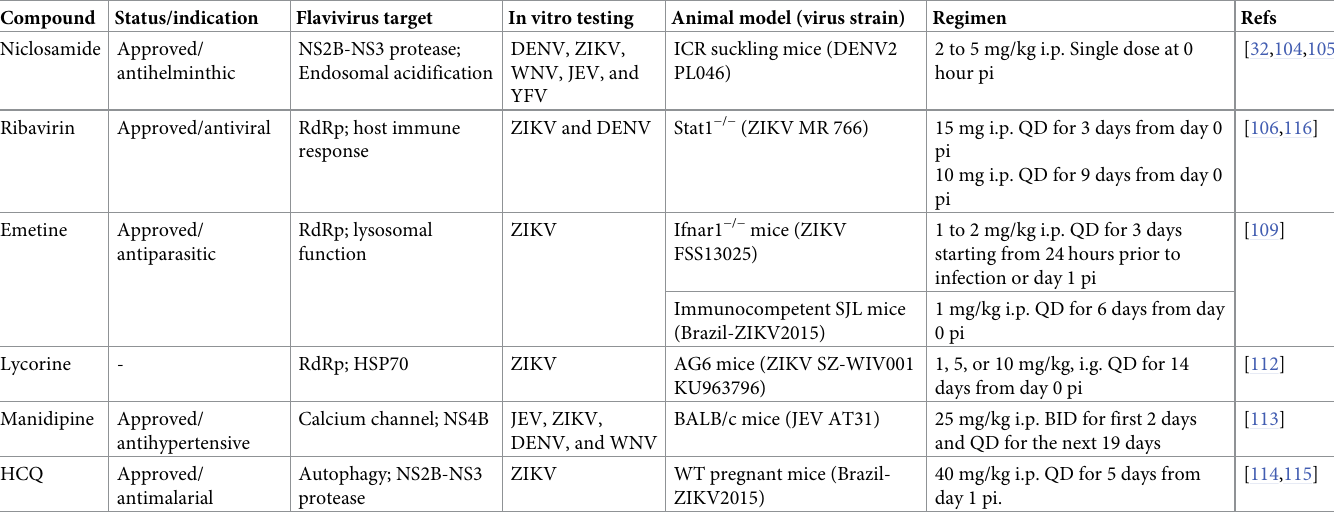
Table 3. Antiviral with multiple mechanisms of